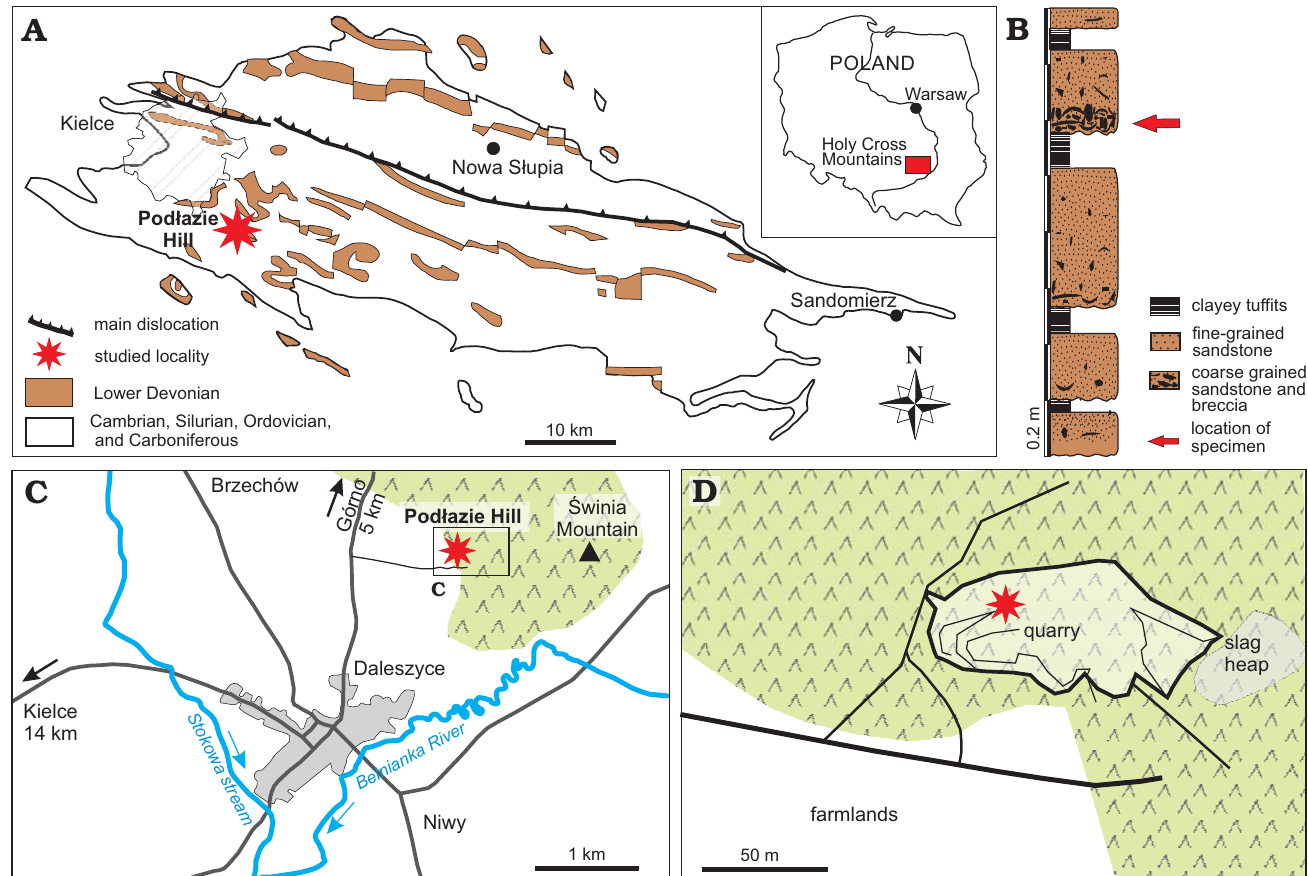
Fig. 1. A . Map of the Holy Cross Mountains showing distribution of Lower Dewonian deposits (modified from Kowalczewski 1971). B . Stratigraphic column at Pod ł azie Hill locality. C , D . Location and occurence of the Pod ł azie Hill